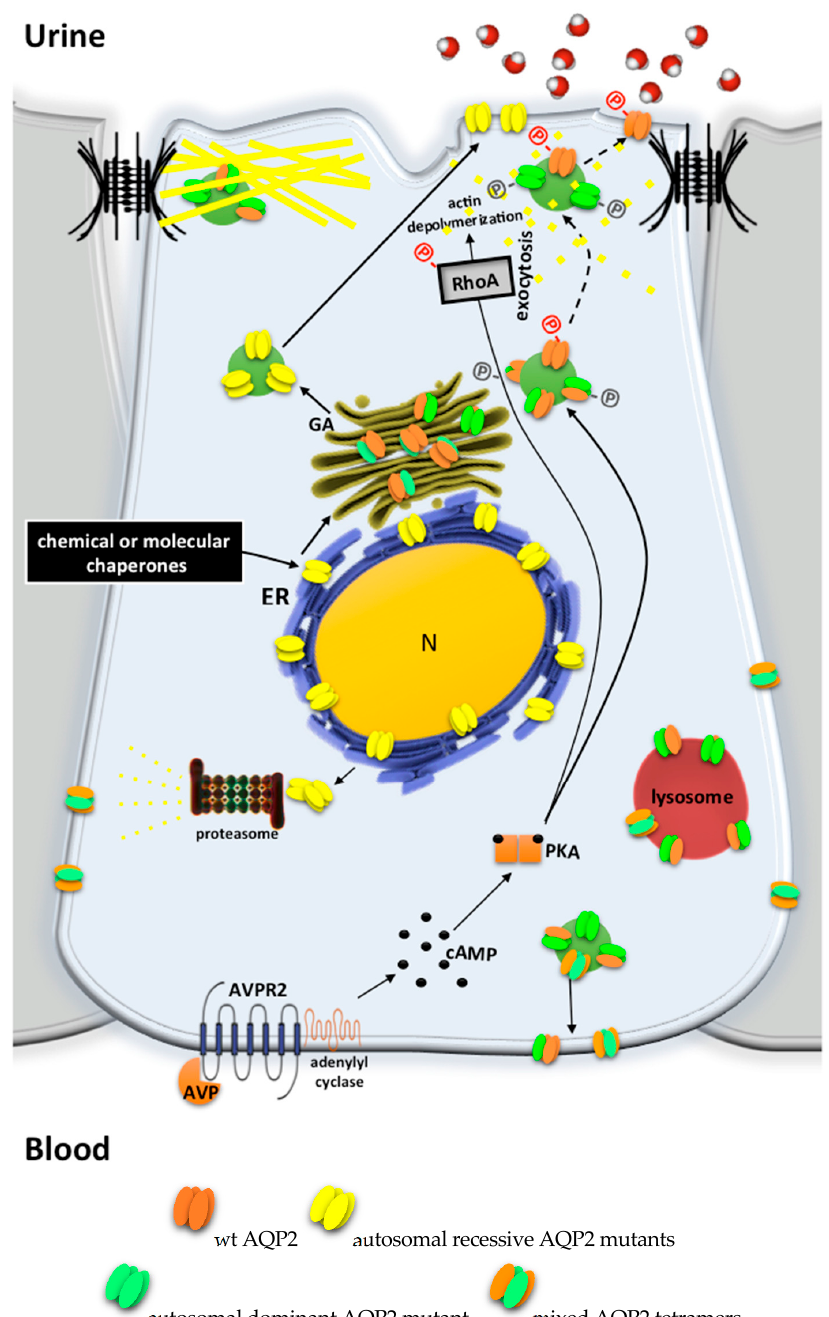
Figure 3. AQP2 mutations explain autosomal recessive and dominant NDI. AQP2 mutations can affect the proper synthesis, processing or plasma membrane localization of the gene product. Most of the AQP2 mutations falling in the protein transmembrane domains are misfolded (yellow tetramers) and retained in the ER until degraded by the proteasome. Affected patients are homozygous or compound heterozygous for these AQP2 mutations. Since most of these mutants still maintain water channel functionality, the therapeutic approach under investigation is based on the use of chemical chaperones aiding release from the ER (full lines). Autosomal dominant NDI is caused by AQP2 mutations affecting the carboxyl terminus (COOH-terminus) of the protein, which is a crucial domain for phosphorylation or apical sorting. A lack of AQP2 exocytosis (dotted lines) prevent the AVP-mediated water reabsorption in the collecting duct principal cells.These AQP2 mutants have a dominant effect over the wtAQP2 subunit and are responsible for AQP2 missorting.